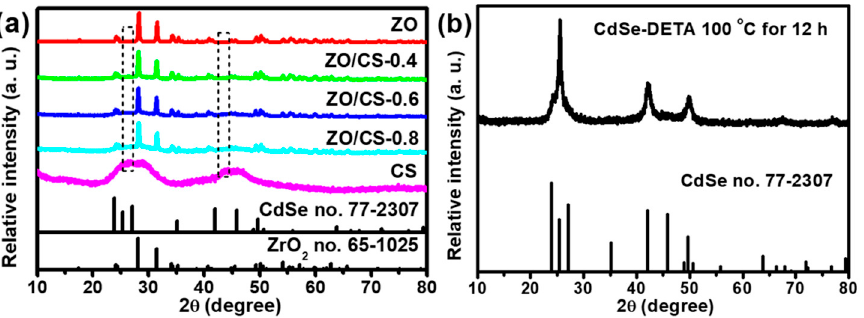
Figure 1. XRD patterns of ( a ) ZO, ZO/CS nanocomposites, and CS; ( b ) CdSe − DETA in 100 °C for 12